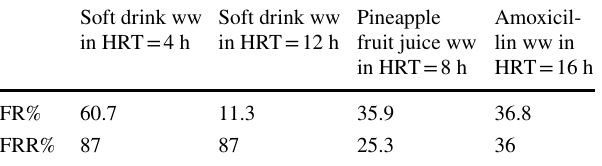
Table 6 The results of FRR% and FR% during long-term filtration in the UF membrane at constant pressure of 30 psi for three types of